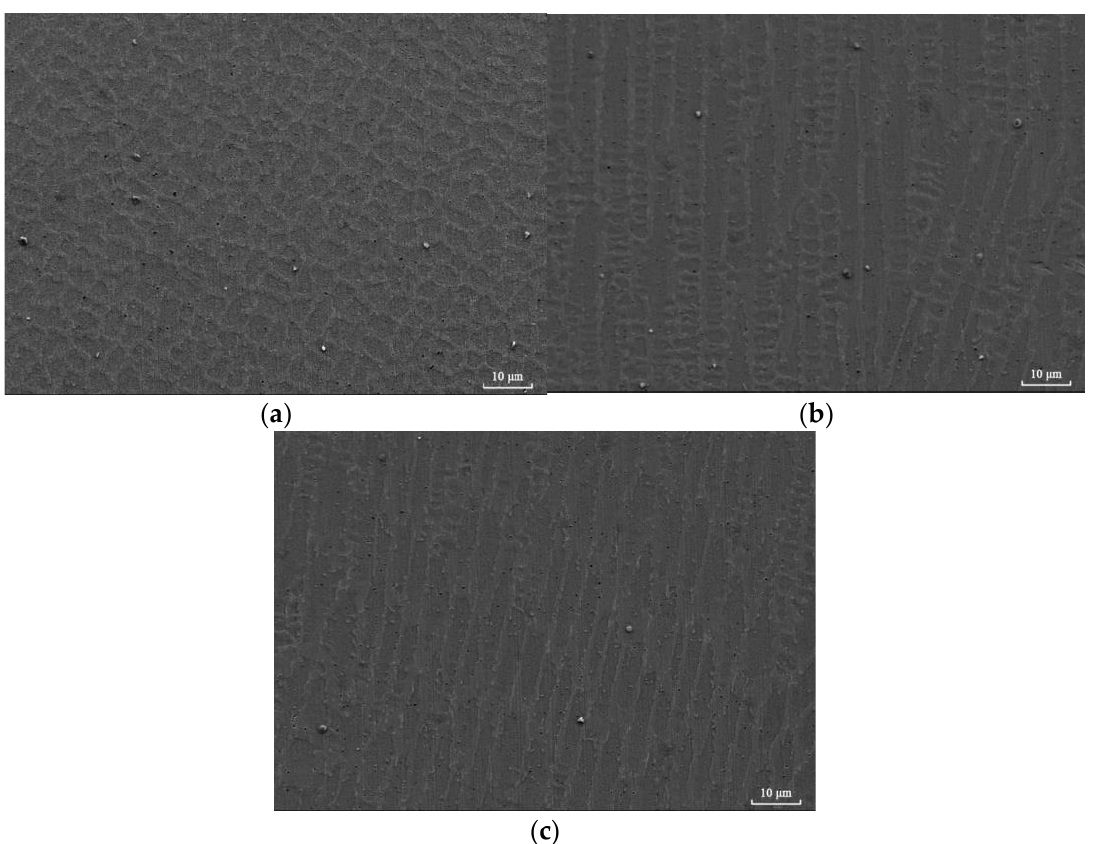
Figure 8. Micro-structure of the laser-UHF induction hybrid deposited layer in ( a ) top region, ( b ) middle region and ( c ) bottom region.